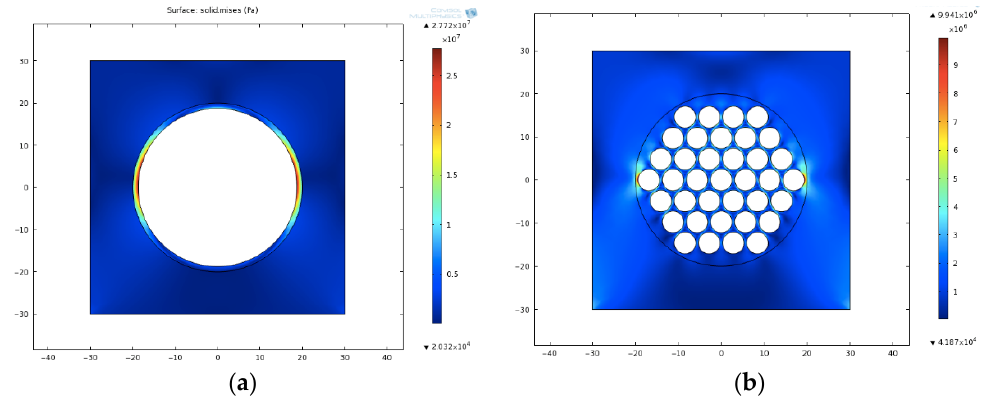
Figure 9. ( a ) The stress field near and in the wall of hollow glass microspheres (HGM) and ( b ) in the glassy CMP, both embedded in the glassy polymer and subjected to uniaxial compression (details in the Experimental).